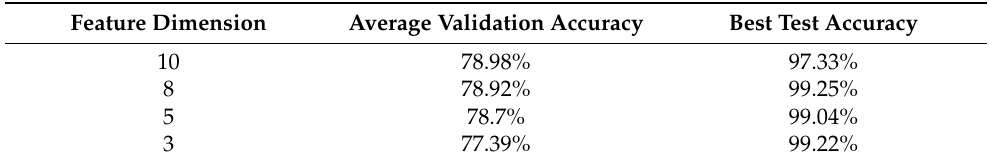
Table 3. Performances of Fully Connected Neural Networks (FCNNs) with different feature di- mensions of PCA.